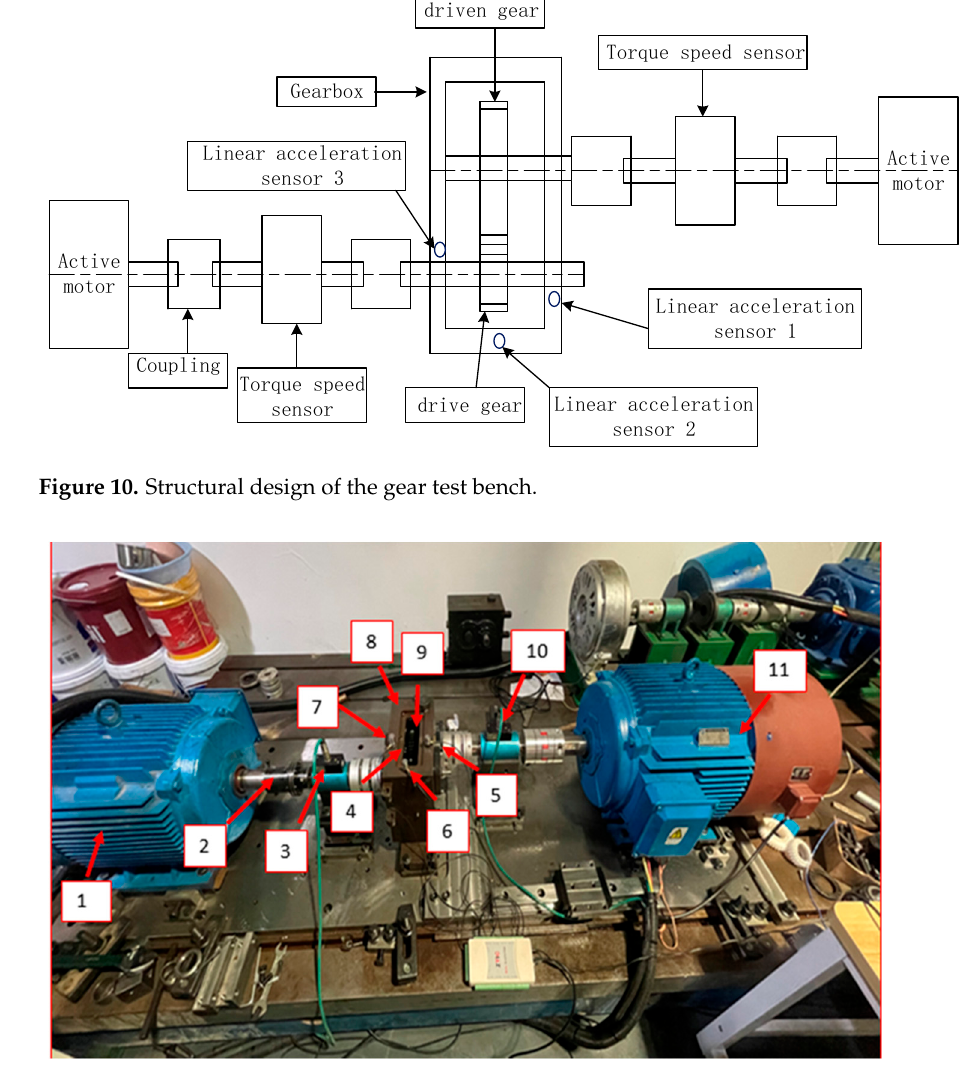
( d ) Figure 12. Gears with different degrees of pitting. ( a ) Normal condition, ( b ) single pitting condition, ( c ) double pitting condition, ( d ) triple pitting condition.